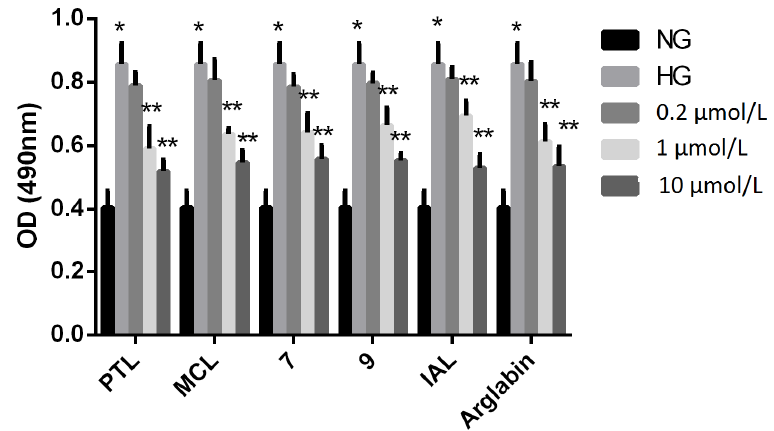
Figure 2. Effect of sesquiterpene lactones on HG-induced regulation of proliferation in MCs at a concentration of 0.2, 1, 10 μ M for 24 h. NG: normal glucose; HG: high glucose. * p < 0.05 vs. NG, ** p < 0.05 vs. HG.